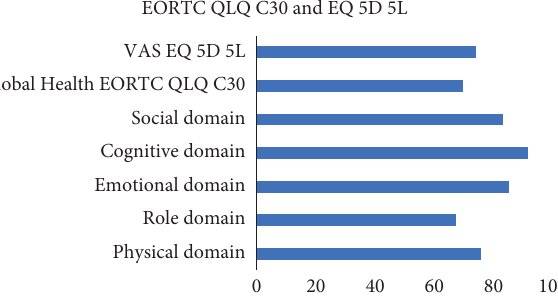
Figure 2: Te global health score and other domains of the EORTC QLQ-C30 and VAS of EQ-5D-5L.